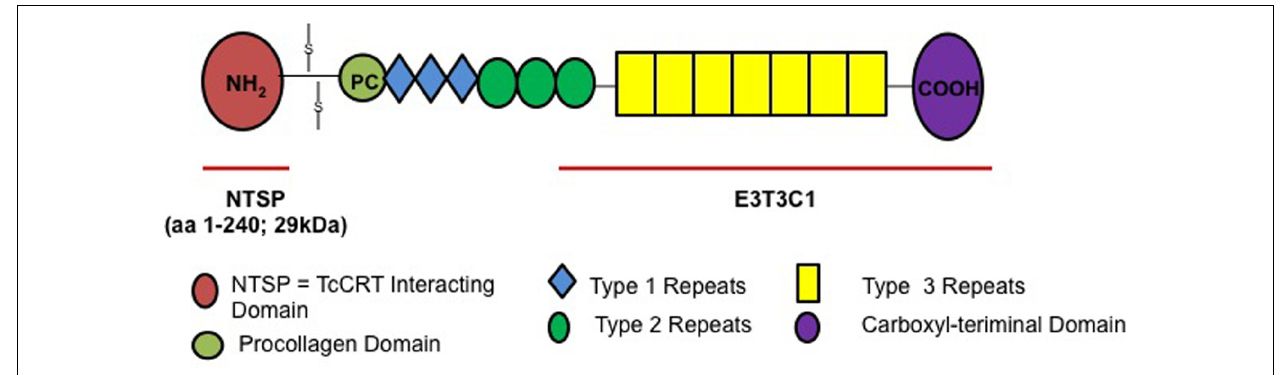
FIGURE 1 |THBS1 structure and NTSP domain that interacts withTcCRT to enhance T. cruzi cellular